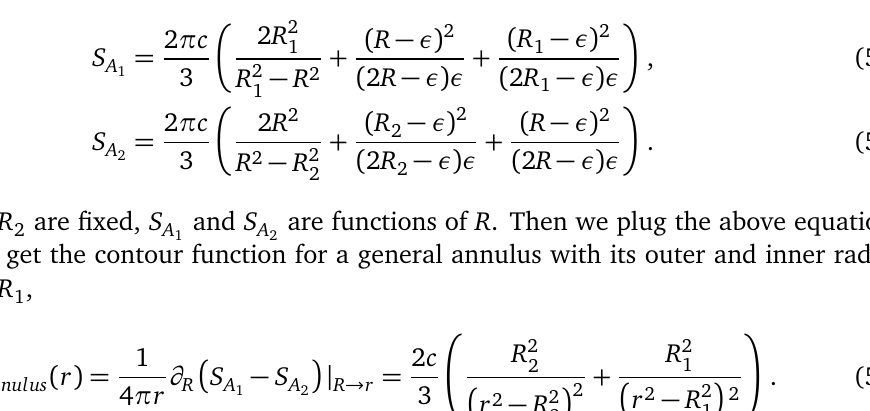
Figure 9: The partition of an annulus A = A thin annuli are the cutoff regions at each boundary. The width of all the cutoff annuli is set to be ε